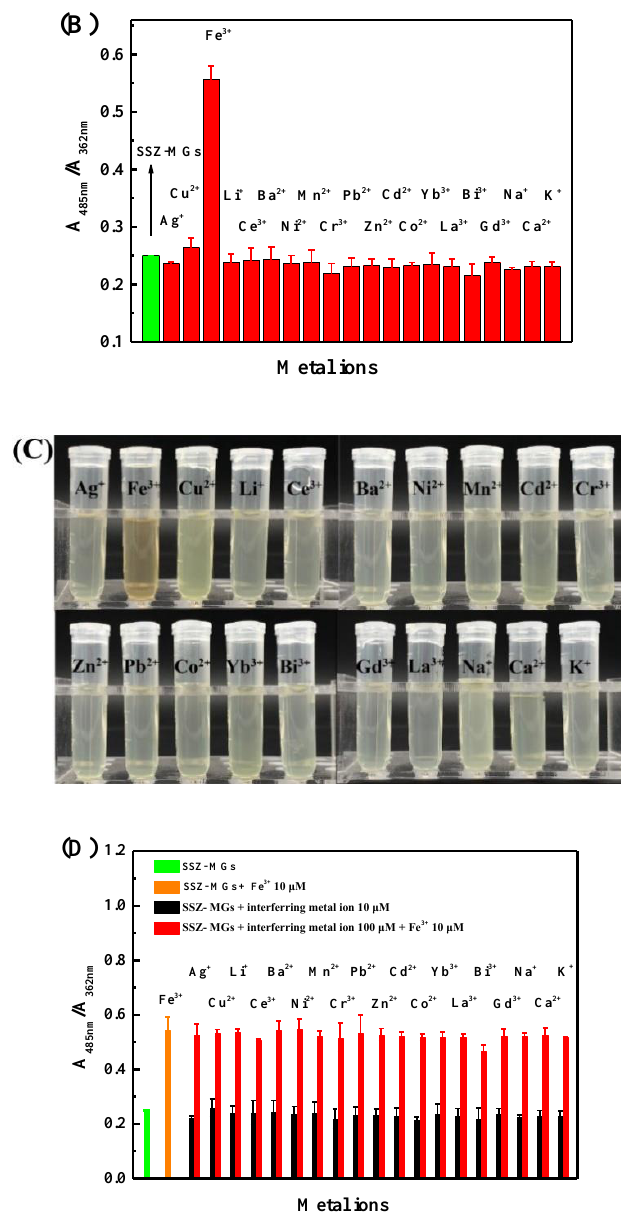
Figure 5. ( A ) UV-vis absorption spectra of SSZ-MG aqeuous suspensions (0.196 mg/mL) at 25 °C and pH of 5.6 with the presence of 10 μM different metal ions, respectively. ( B ) The corresponding A 485nm /A 362nm ratios calculated from the spectra shown in (A). ( C ) The photographs of SSZ-MG aqueous suspensions (0.196 mg/mL) after addition of 10 μM various metal ions, respectively. ( D ) The interference studies of different metal ions (100 μM) on the response of SSZ -MG aqueous suspensions (0.196 mg/mL) to Fe 3+ ions (10 μM) at 25 °C and pH of 5.6.